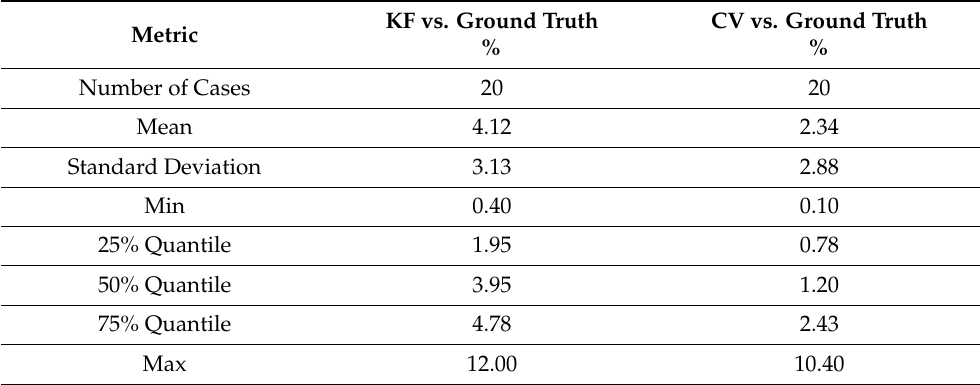
Table 6. Residuals of Instances with Superior KF Outcomes (Hourly Case). KF vs. Ground Metric